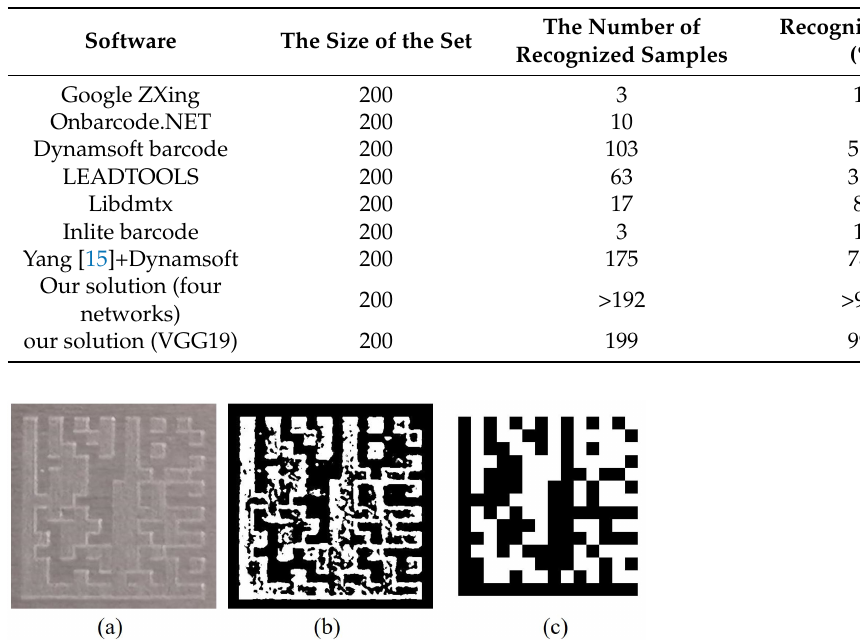
Table 4. The recognition results in the CNN test set.